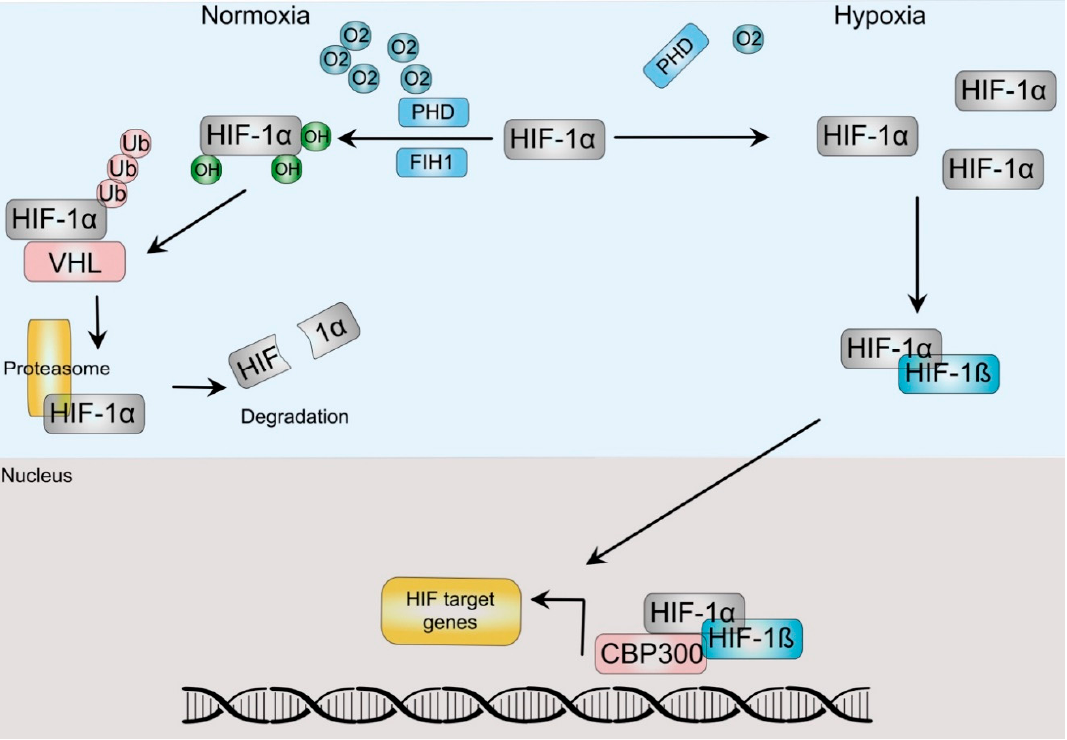
Figure 1. HIF-dependent hypoxia signaling pathway. In normoxia, prolyl-hydrolyses (PHD) and Factor-inhibiting hypoxia-inducible factor (FIH) hydroxylate HIF- α . Hydroxylation from the latter impairs HIF transactivation of target genes, whereas the former allows dimerization with the Von Hippel Lindau (VHL) protein, which directs HIF to ubiquitination and degradation by the proteasome. Hypoxic conditions stabilize HIF- α after PHD and FIH inactivation, allowing dimerization with HIF-ß subunits, translocation to the nucleus and association with coactivators, such as p300/CBP to regulate gene expression.